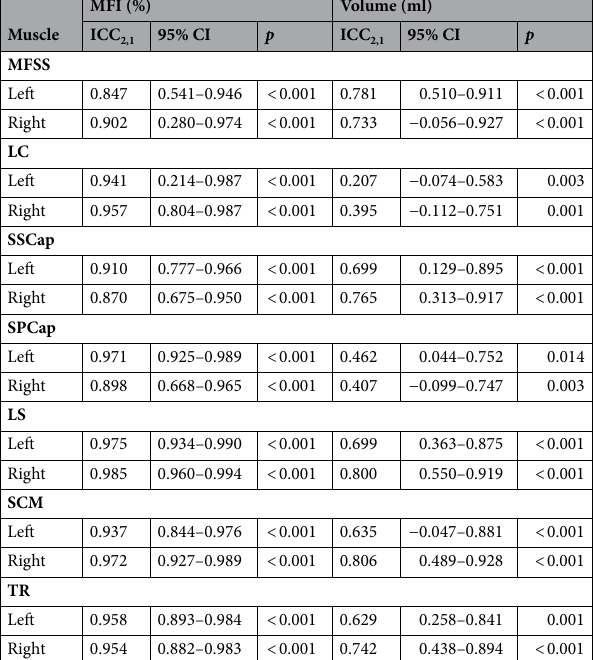
Table 3. CNN MFI and volume reliability. Intraclass correlation coefficients (ICC 2,1 , two-way random, absolute agreement, single measure) were used to assess the reliability of the convolutional neural network (CNN) model compared to the ground truth (GT) for the muscle fat infiltration (MFI) and muscle volume measures on the testing dataset (n = 18). CI = confidence interval. p = F-test with true value of